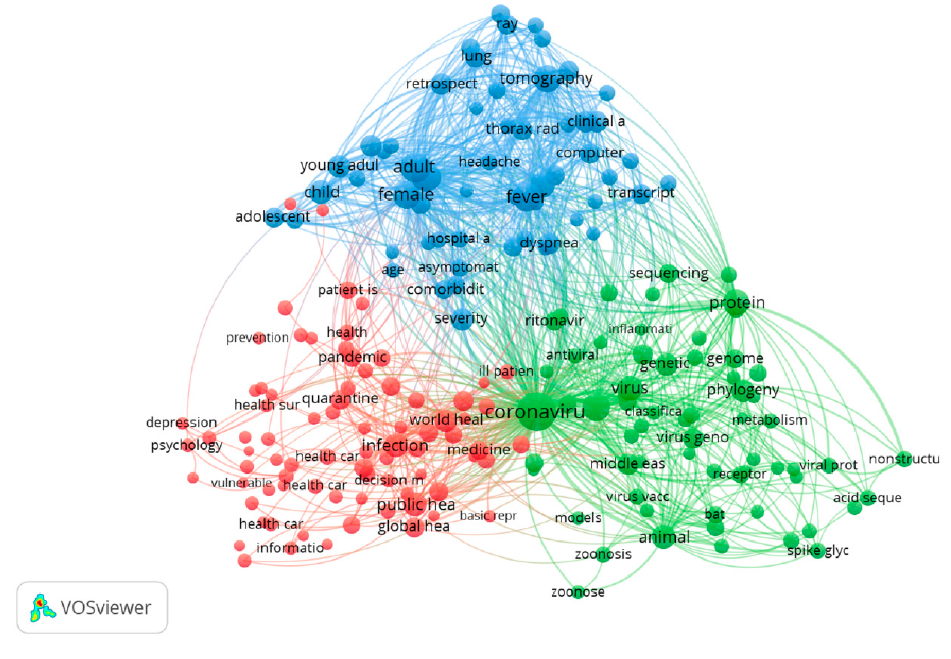
Int. J. Environ. Res. Public Health 2020 , 17 , 4095 Figure 3. Co-occurrence analysis of keywords. Figure 3. Co-occurrence analysis of keywords.